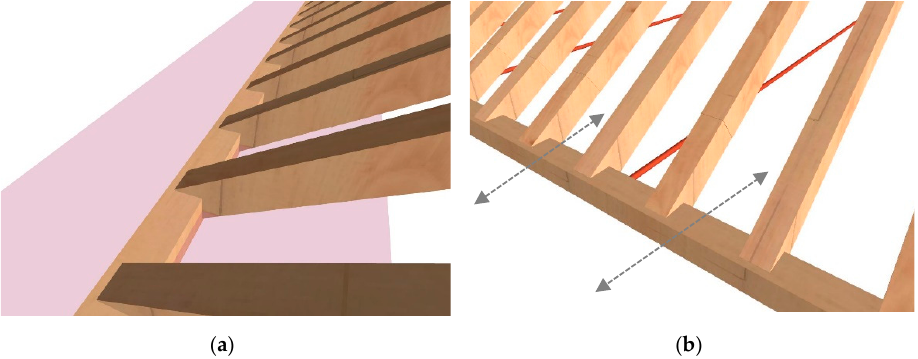
Figure 20. Different hypotheses modelled: ( a ) hypothesis 1 with the massive wall link; ( b ) hypothesis 2, with freedom of movement.